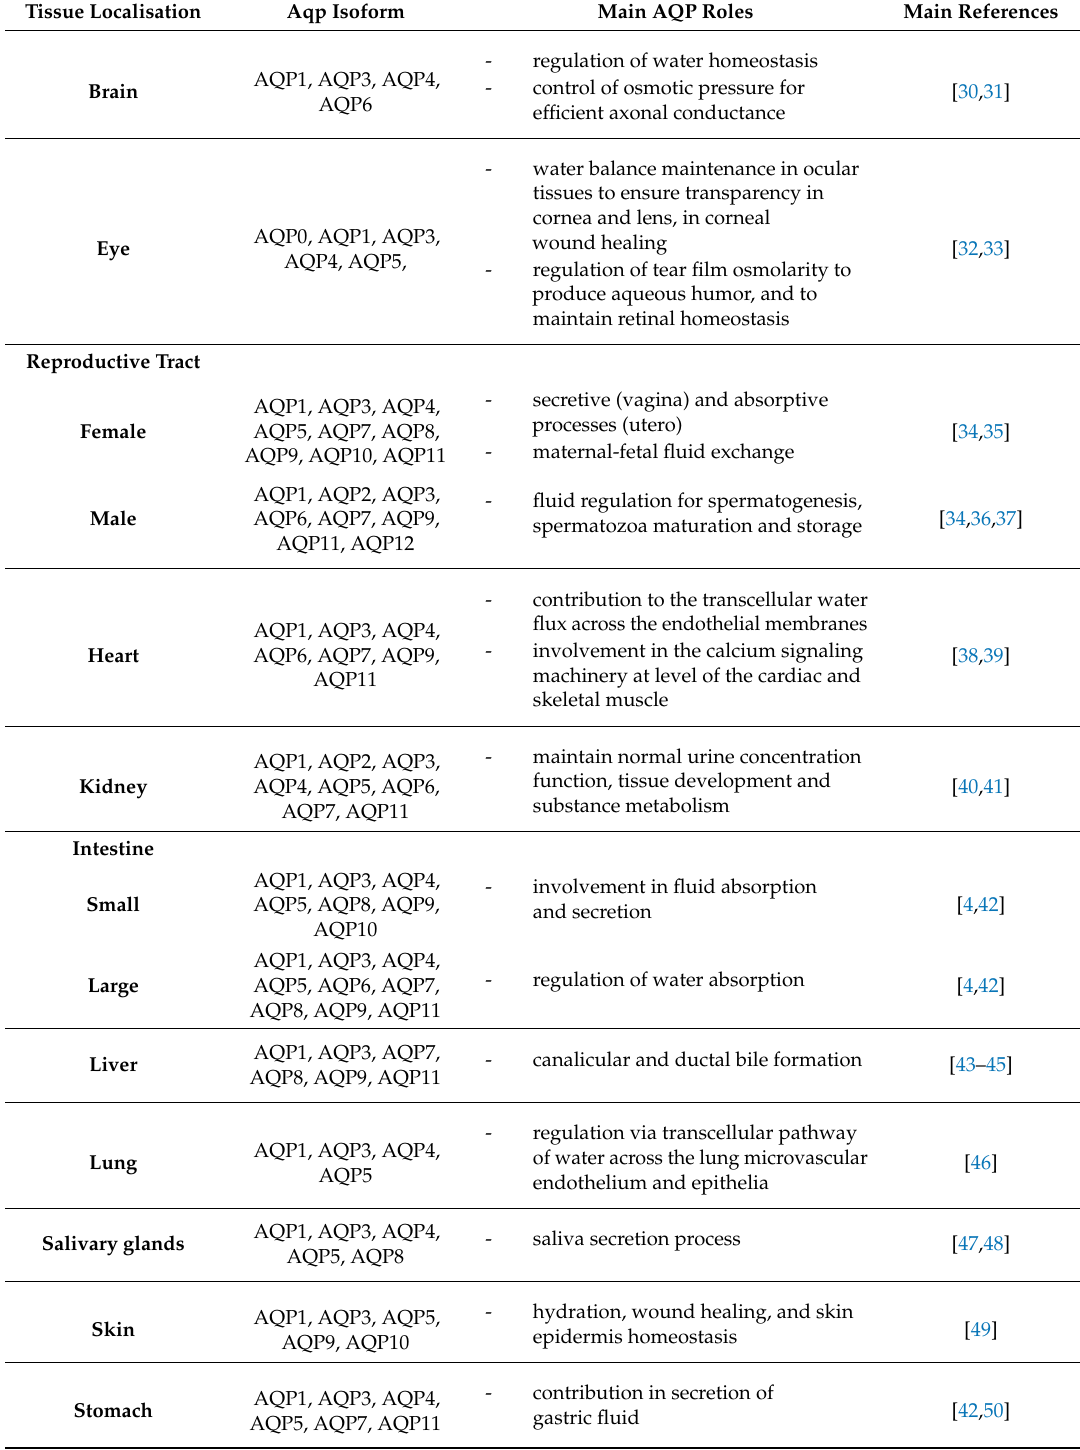
Table 2. Distribution and principal roles of AQPs in the main body